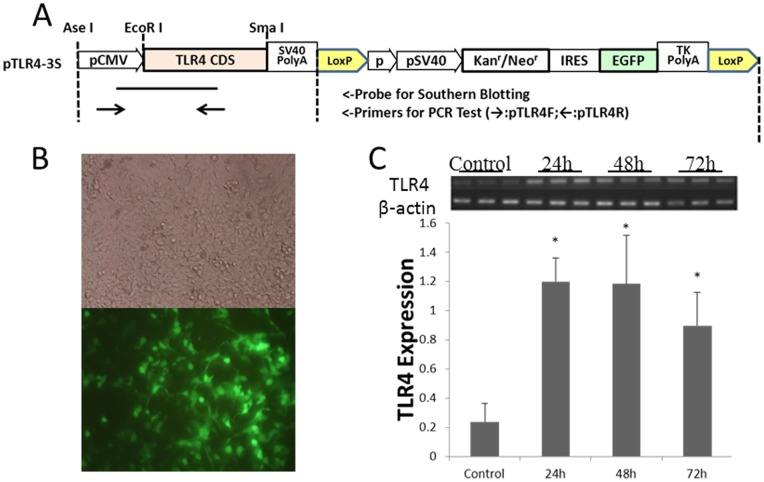
TLR4 expression vectors validation in 293FT cell.A) Construct pTLR4-3S vector; TLR4 expression structure in 293FT cell and its efficiency. B) Construct expressing green fluorescent protein in the 293FT cell (200×). C) pTLR4-3S transfected into 293FT cells. TLR4 expression was detected by RT-PCR. Gray value results confirmed TLR4 overexpressed for at least three days.